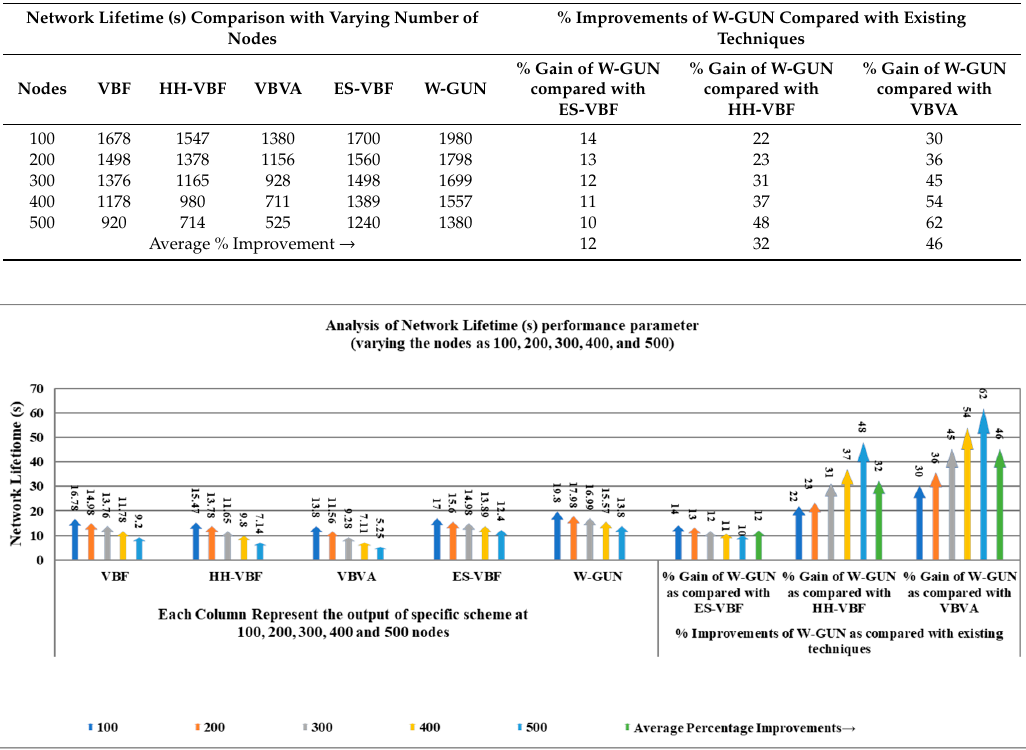
Figure 10. Detailed percentage-centric performance gain of W-GUN focusing network lifetime.